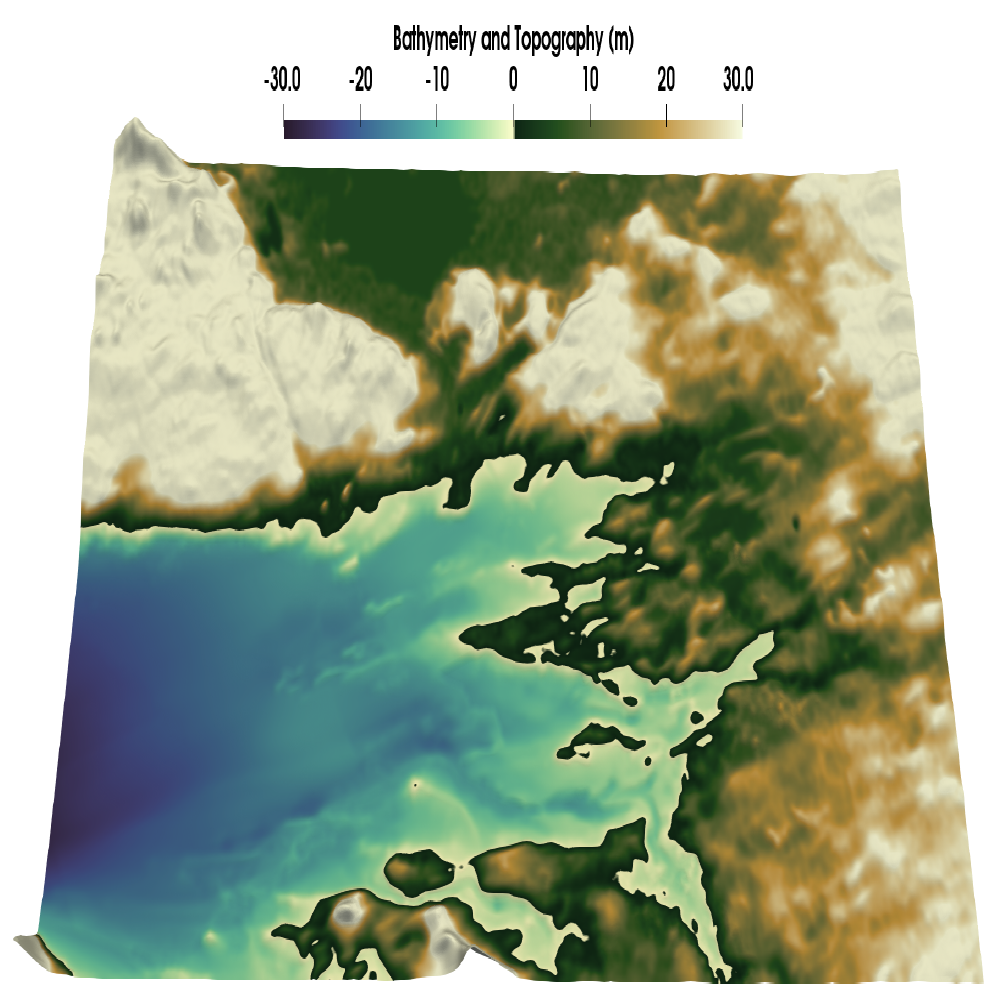
Figure 7. The high resolution bathymetry and topography grid generated for Galway Bay. The grid has been scaled in the vertical direction to give a 3D